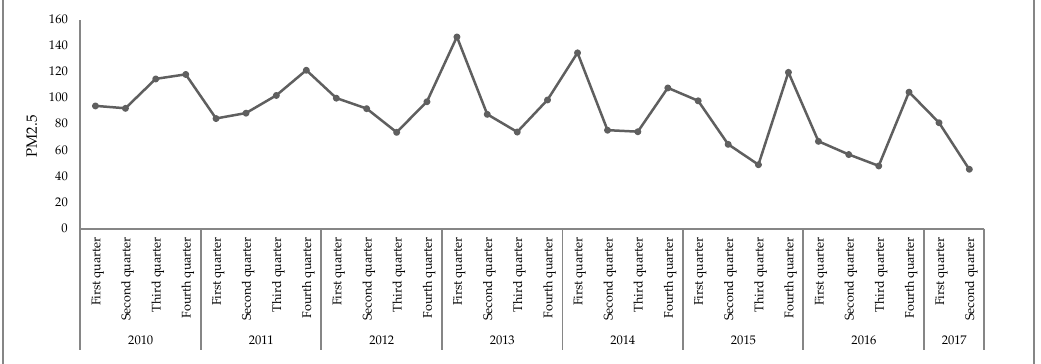
2.5 during 2010–2017.